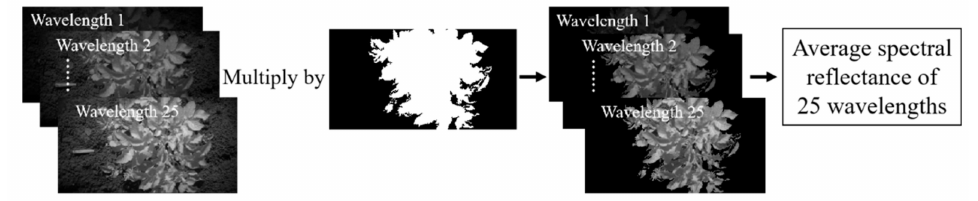
Figure 5. The spectral reflectance extraction